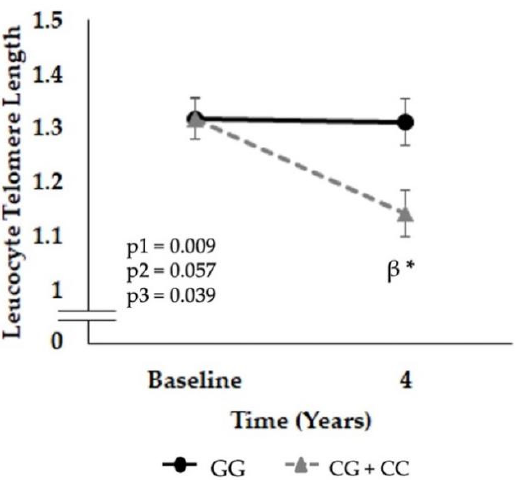
Figure 1. Leucocyte telomere length according to the single nucleotide polymorphism (SNP) rs7069102 genotype located on the SIRT1 gene after the follow-up period. Data are represented as the mean ± SEM and correspond to ANOVA for repeated measures; where p1: time follow-up, p2: genotype influence and p3: the interaction of the two factors (time vs. genotype). When post hoc tests were pertinent, we used multiple comparisons with the Sidak correction. * p < 0.05 4 years vs. baseline, β p < 0.05 genotypes in the same time. The data correspond to the population included in the study where 351 subjects are carriers of the GG genotype (49%) and 365 of the CG + CC genotype (51%) (combined both LF and Med